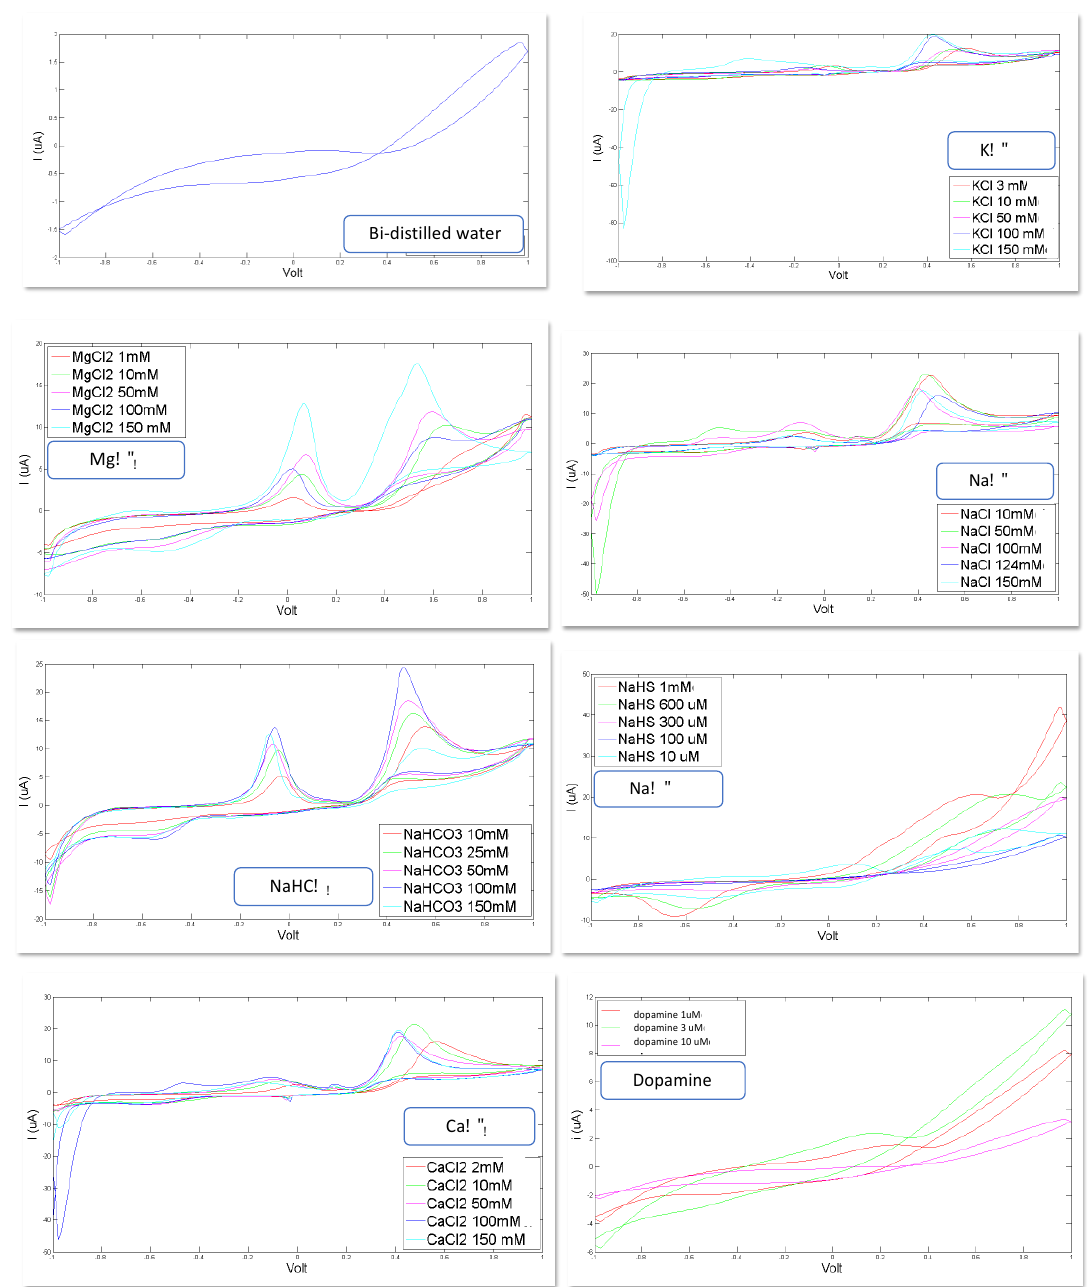
Figure 2. Voltammograms registered for the following constituents for different concentration levels: reference bi-distilled water KCl (3, 10, 50, 100, 150 mM, MgCl 2 (1, 10, 50, 100, 150 mM), NaCl (10, 50, 100, 124, 150 mM), NaHCO 3 (10, 25, 50, 100, 150 mM), NaHS (10 µM, 100 µM, 300 µM, 600 µM, 1 mM), CaCl 2 (2, 10, 50, 100, 150 mM), Dopamine (1 µM, 3 µM, 10 µM).